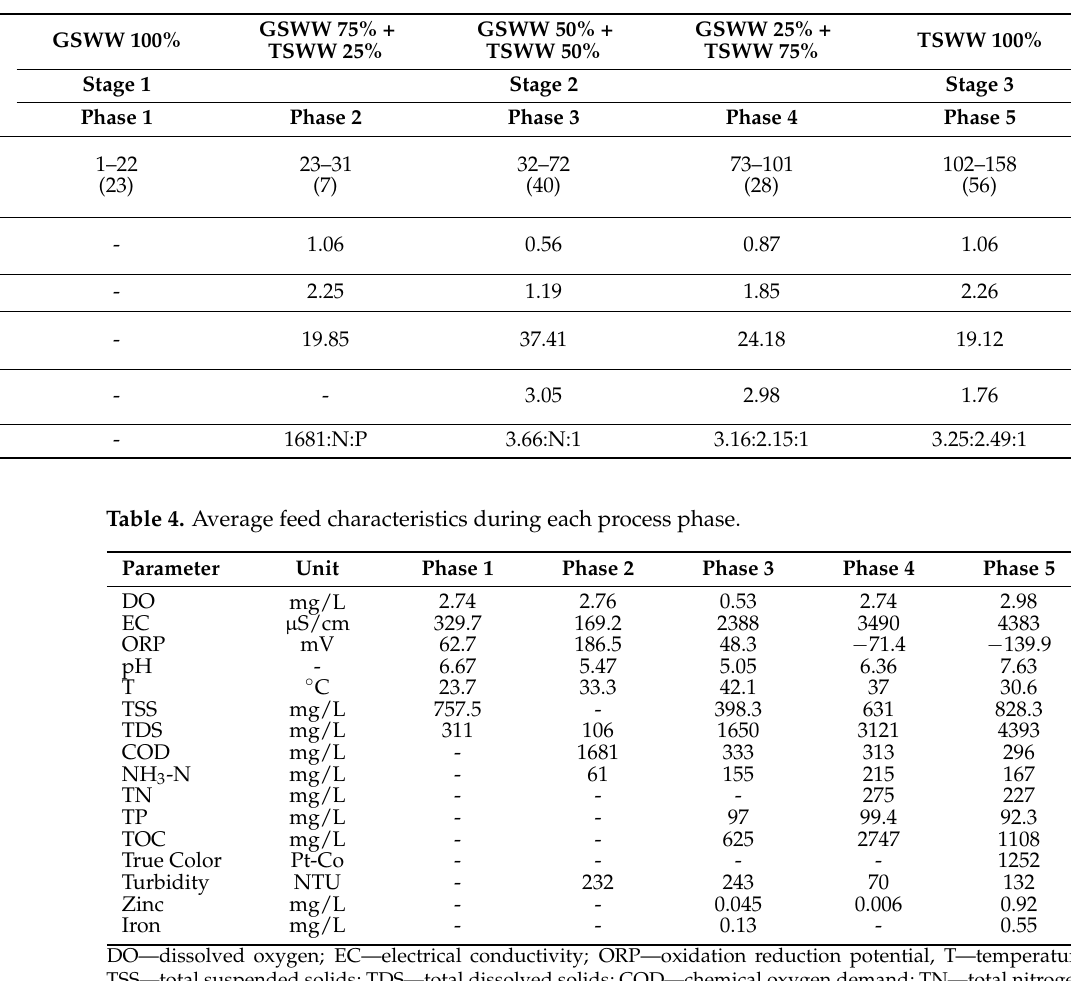
Table 3. Operational phases and variation in system parameters during the experiment.